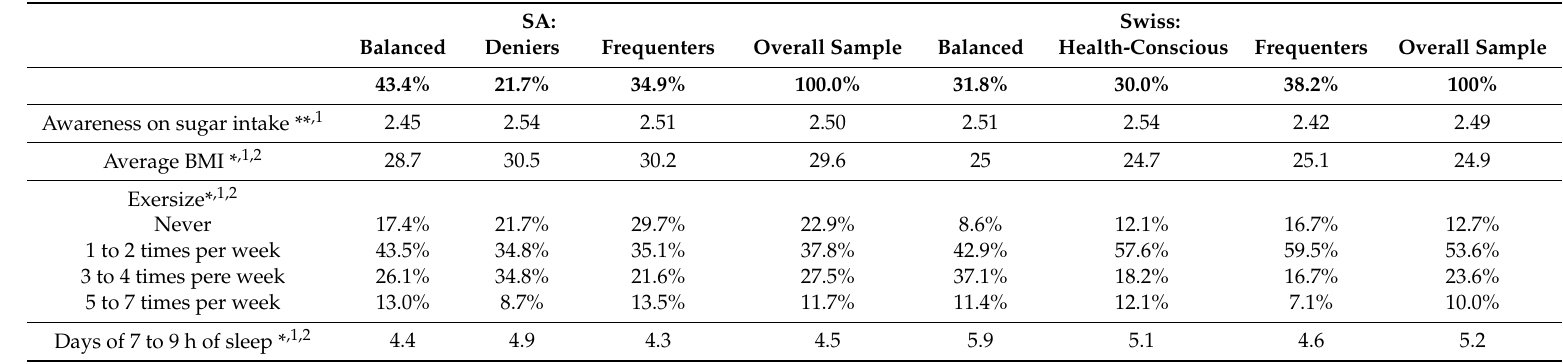
Table A1. Mean scores on the clustering scales and contrast analysis results by clusters of respondents’ BMI score, frequency of exercise, and adequate sleep per